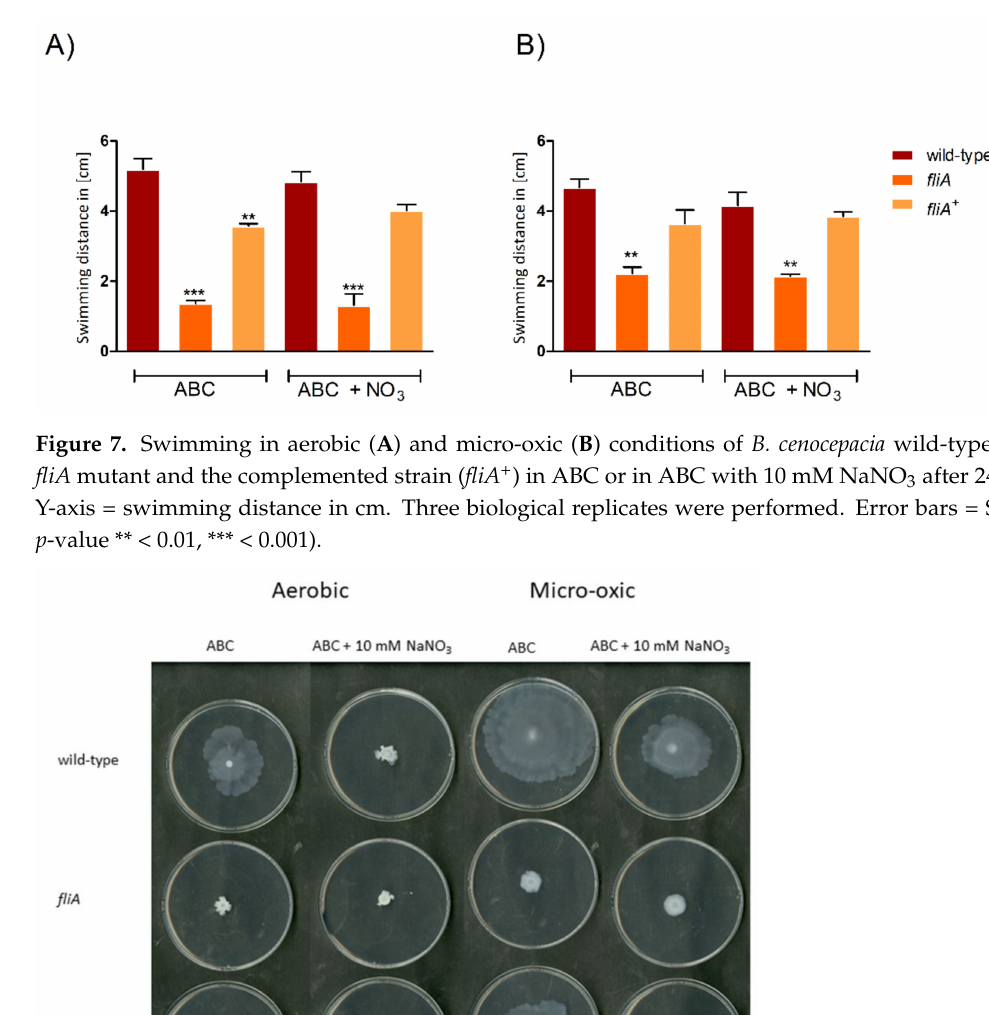
Figure 6. Transmission electron microscopy images of B. cenocepacia H111 wild-type, a fliA insertional mutant and a complemented strain fliA + . Two biological replicates were performed. FEI Tecnai G2 Spirit TEM (FEI, Hillsboro, OR, USA) at 120 kV acceleration voltage with the detector side-mounted digital camera Gatan Orius 1000 (4 k × 2.6 k pixels) was used. Scale bars represent 1 µ m.